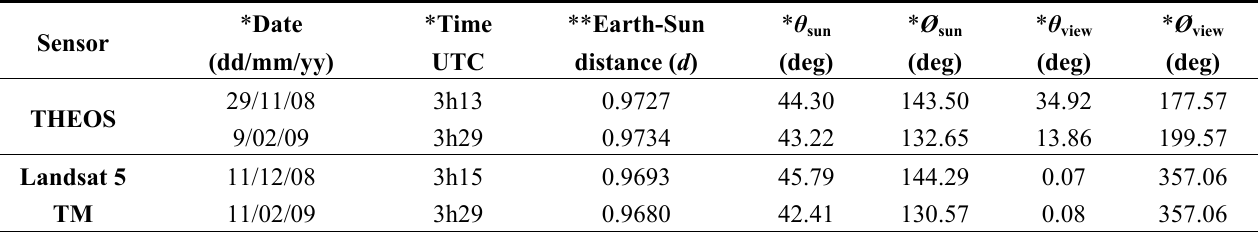
Table 5. Acquisition dates, times, Earth-Sun distances ( d ), and sun and view geometrics ( θ : zenith angle and Ø : azimuth